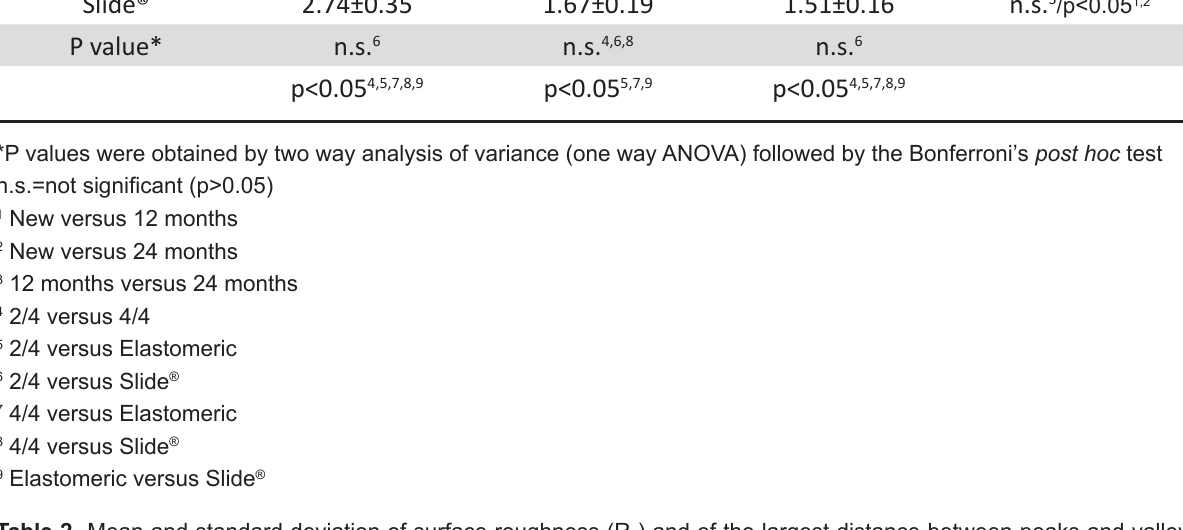
*P values were obtained by two way analysis of variance (one way ANOVA) followed by the Bonferroni’s post hoc test n.s.=not significant (p>0.05)